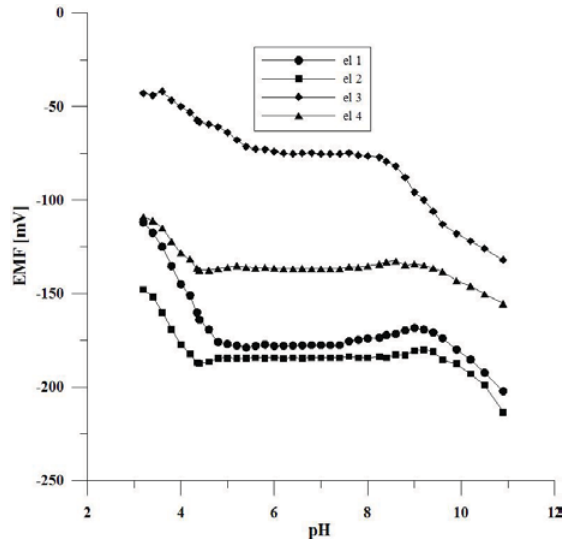
Figure 6. Dependence of EMF on pH of studied electrodes.